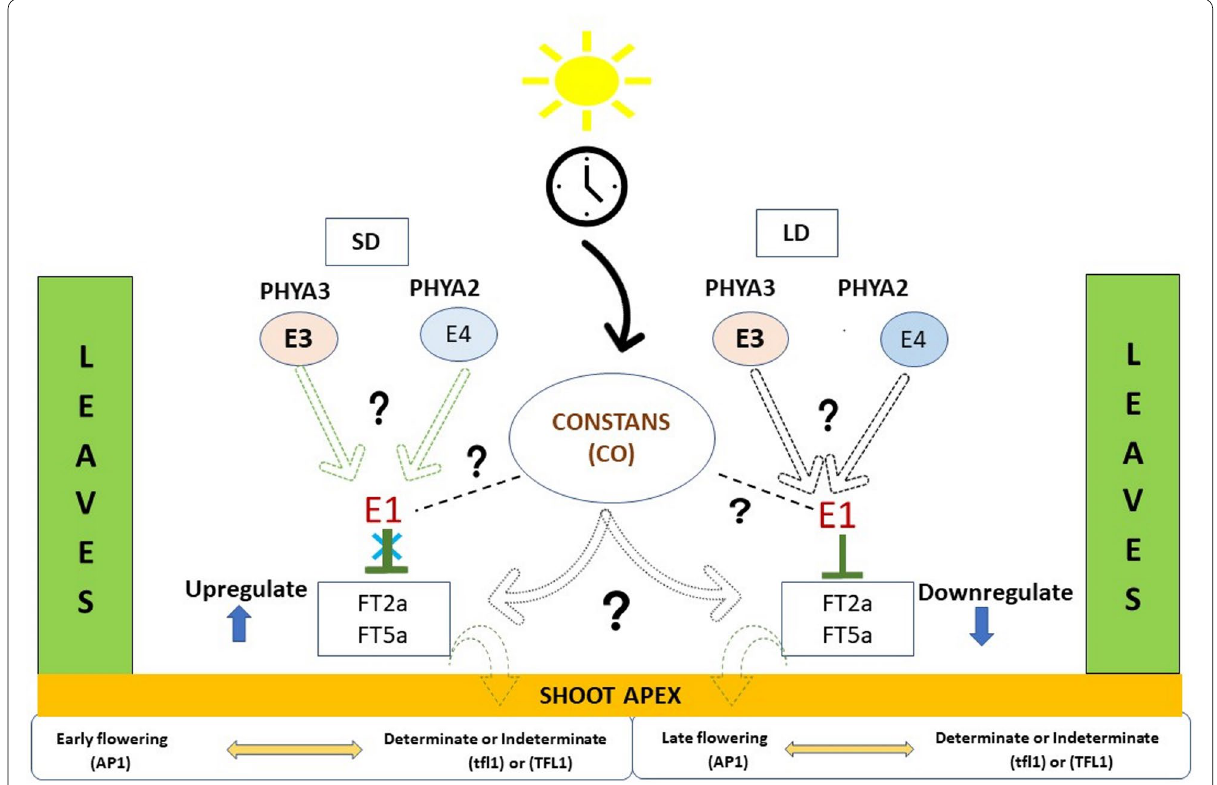
Fig. 5 A theoretical model for photoperiod responsive flowering and growth habit mediating plant architecture in response to short day (SD) and long day (LD) conditions based on genes reported in Lablab purpureus , Glycine max and related legumes. Light arrows in SD indicate repressed E3 and E4 during short days. Question marks indicate the unknown genes involved in mediating the process. Genes E4 , E1 , FT2a and FT5a are yet to be identified in Lablab purpureus . PHYA3 and PHYA2 are homologs of phytochrome A. E1 , E3 and E4 are maturity loci governing photoperiodic regulation in Glycine max . FT2a and FT5a are Flowering locus T homologs reported as florigens in many legumes and induce